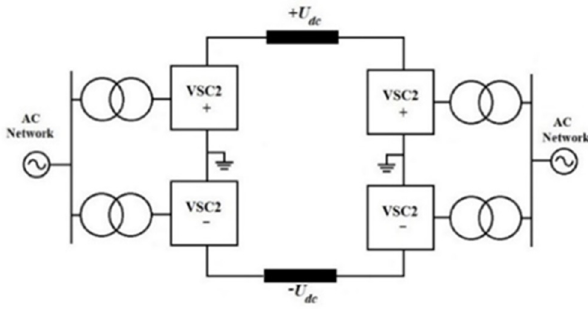
Figure 27. VSC- HVDC—true bipolar connection.